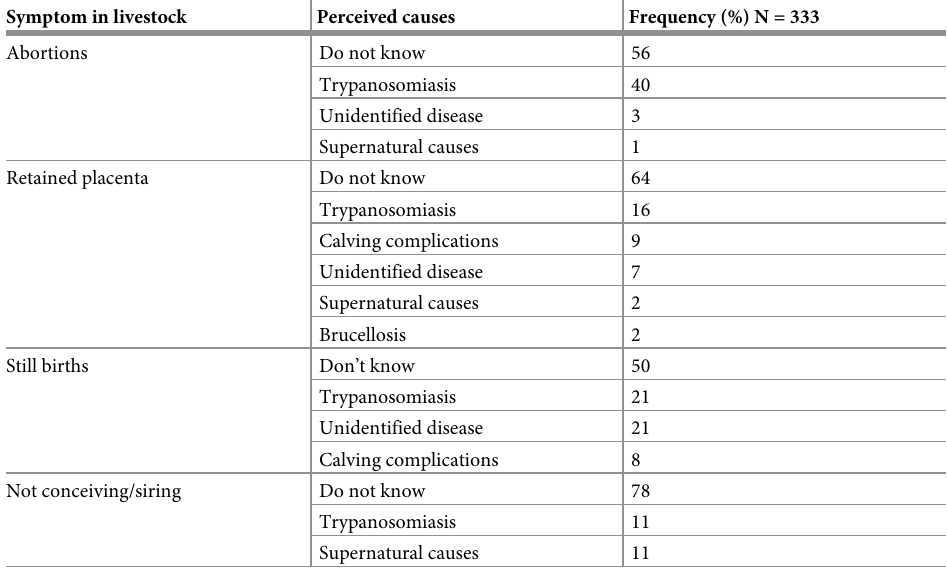
Table 4. Answers to open questions on the perceived sources of common signs of brucellosis among agro-pasto- ralists in the Kilombero district,